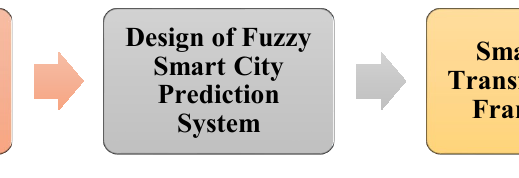
Figure 1. Methodology. Figure 1.